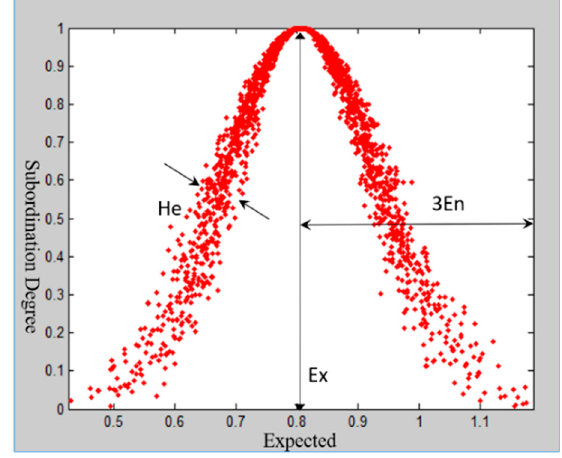
Figure 6. Digital characteristic map of the cloud model.